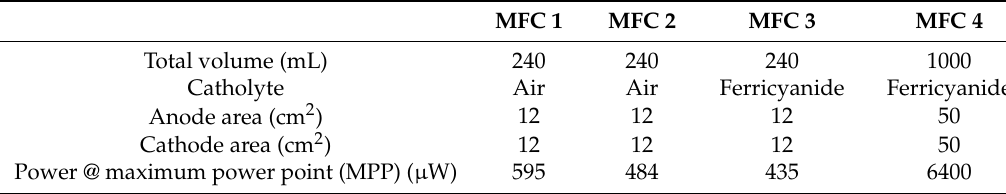
Figure 2. Two-chamber microbial fuel cell and power management unit set up. Table 1. Specifications and performance of MFCs.